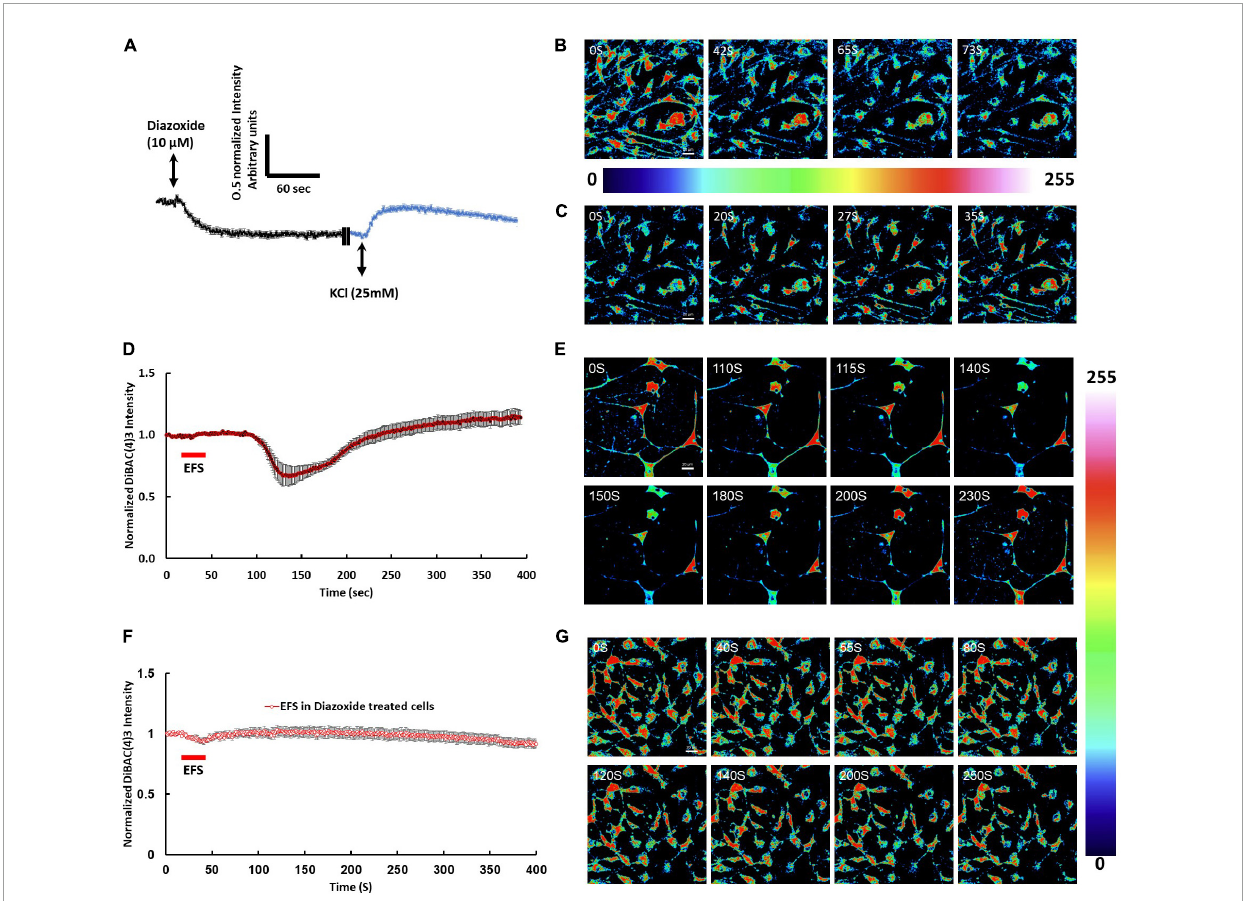
FIGURE2 Membrane potential changes in response to pharmacological stimulation and EFS. (A) The graph shows average intensity changes of the membrane potential dye DiBAC4(3) in response to pharmacological stimulation to induce hyperpolarization or depolarization of the membrane using Diazoxide or KCl, respectively in rat cortical cultures. The graph shows traces of two sequential experiments where, in the first experiment, cells were stimulated with 10 µ M Diazoxide followed by washing in Krebs buffer then in the second experiment, cells on the same field of view were stimulated with 25 mM KCl. Diazoxide and KCl were added at second 20 of the time lapse recording experiment. Data shown in (A) represent the average of one independent experiment and is expressed as normalized fluorescence intensity ratio relative to the averaged three images obtained prior to EFS. (B) Sequential confocal images of DiBAC4(3) labeled cortical neurons at the indicated time intervals corresponding to before, during and after addition of 10 µ M Diazoxide. (C) Sequential confocal images of DiBAC4(3) labeled cortical neurons at the indicated time intervals corresponding to before, during and after addition of 25 mM KCl. Scale bar = 20 µ m. Intensity changes in (B,C) are color-coded whereby high levels are red and low levels are blue. (D) The graph shows average intensity changes of DiBAC4(3) in response to EFS with intensity of 7.69 V/cm. The EFS was applied at second 20 of the experiment for a duration of 20 s. Data shown in (D) represent the average of one independent experiment and is expressed as normalized fluorescence intensity ratio relative to the averaged three images obtained prior to EFS. (E) Sequential confocal images of DiBAC4(3) labeled cortical neurons at the indicated time intervals corresponding to before, during and after exposure to EFS with ± 5 V. Scale bar = 20 µ m. (F) The graph shows average intensity changes of DiBAC4(3) in response to EFS with ± 5 V in cells pretreated with 10 µ M Diazoxide for 10 min. The EFS was applied at second 20 of the experiment for a duration of 20 s. Data shown in (F) represent the average of one independent experiment and is expressed as normalized fluorescence intensity ratio relative to the averaged three images obtained prior to EFS. (G) Sequential confocal images of DiBAC4(3) labeled cortical neurons at the indicated time intervals corresponding to before, during and after exposure to EFS with ± 5 V. Scale bar = 20 µ m. Intensity changes in (E,G) are color-coded whereby high levels are red and low levels are blue. Experiments were conducted in three independent brain preparations, each with three technical repeats. EFS, electric field